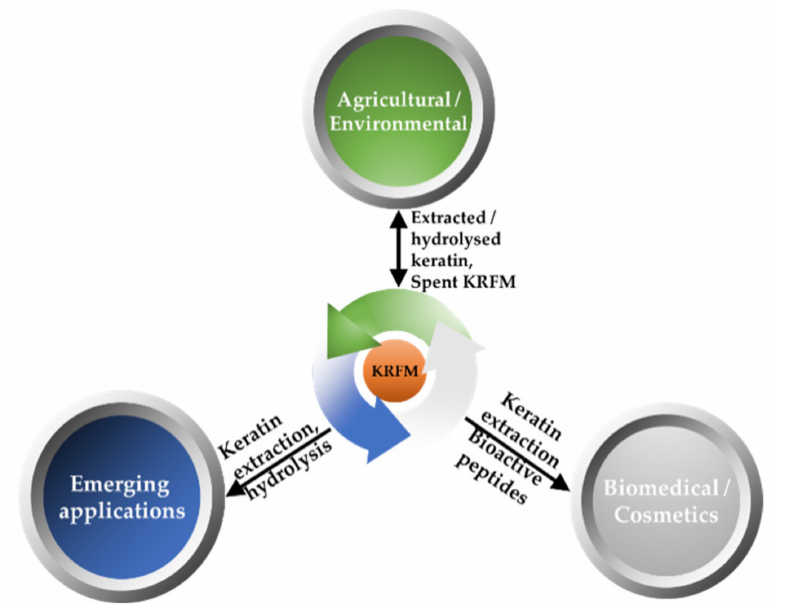
Figure 4. Circular utilization of the keratin-rich fibrous material (KRFM). The emerging application of extracted/hydrolyzed keratin is related to 3D and 4D printing, and stabilization of metallic nanoparticles. Cosmetic and biomedical applications are related to the high biocompatibility of keratin biomaterials, bioactive peptides derived from keratin, healing promoting ability of γ -keratin. Agricultural and environmental applications benefit from film-forming and water holding abilities of